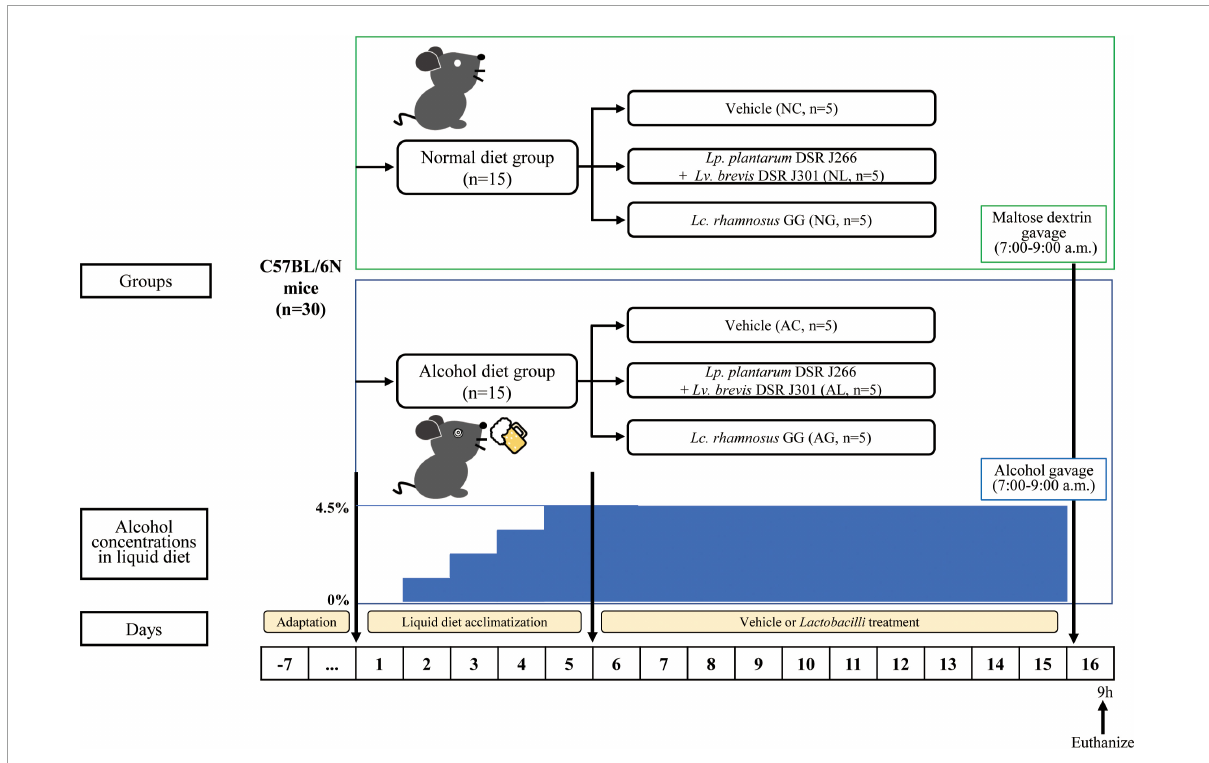
FIGURE1 Experimental procedure. All C57BL/6N mice are initially fed the Lieber-DeCarli diet ad libitum for 5 d to acclimatize them to a liquid diet and tube feeding. Before the acclimatization period, the mice were randomly divided into the following two diet groups ( n = 15 per group): normal diet group (mice were fed Liber-DeCarli control diet) and alcohol diet group (mice were fed Liber-DeCarli diet containing alcohol). The alcohol concentration in the alcohol diet group was gradually increased to 4.5% for 5 days to enable animals adapt to the alcohol diet. The two groups were further randomly subdivided into each of the following three LAB-treatment groups, resulting in a total of six groups ( n = 5 per group): normal diet and vehicle (NC); normal diet and Lp . plantarum DSR J266 + Lv . brevis DSR J301 (NL); normal diet and Lb . rhamnosus GG (NG); alcohol diet and vehicle (AC); alcohol diet and Lp . plantarum DSR J266 + Lv . brevis DSR J301 (AL); and alcohol diet and Lb . rhamnosus GG (AG). Mice in the alcohol diet groups (AC, AL, and AG) were allowed free access to the Lieber-DeCarli diet containing 4.5% (vol/vol) ethanol for 10 days, while those in the normal diet groups (NC, NL, and NG) were pair-fed with the isocaloric control diet replacing ethanol with maltose dextrin. On day 16, ethanol-fed and pair-fed mice were gavaged in the early morning with a single dose of ethanol (5 g kg - 1 body weight) or isocaloric maltose dextrin, respectively, and 9 h later, the mice were euthanized. Next, blood, liver tissue, and fecal samples were collected for subsequent